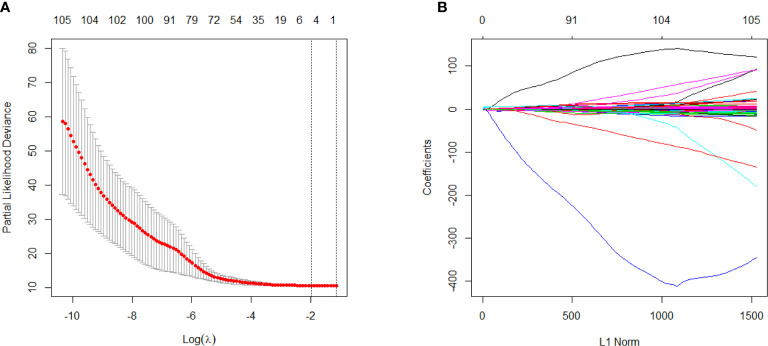
Selection of survival associated radiomics features using the elastic net method, (A) Tuning parameter (λ) in the elastic net used 10-fold cross-validation via maximum area under curve and criterion of minimum standard deviation were followed; (B) The coefficient profiles of 105 radiomics features against the L1 norm (inverse proportional to log λ).